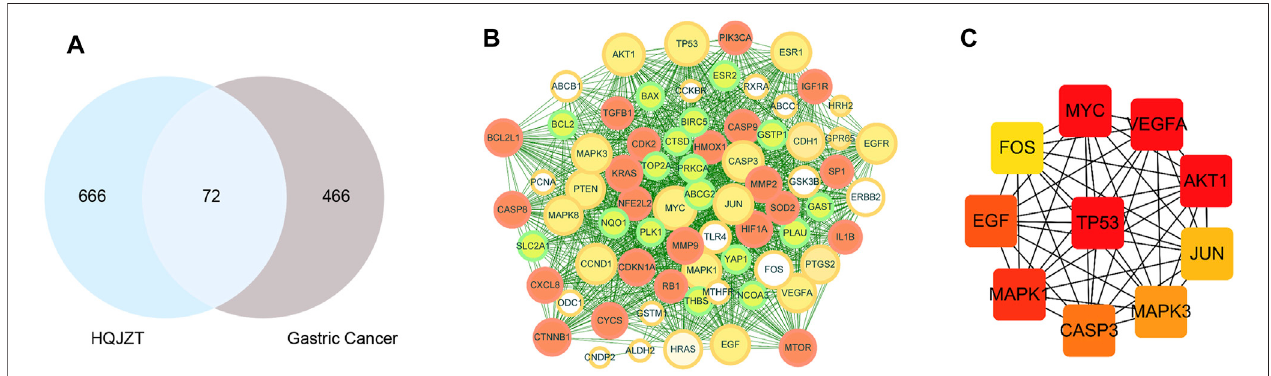
FIGURE 1 | (A) Venn diagram of the targets of Huangqi Jianzhong Tang (HJT) for the treatment of gastric cancer (GC). A total of 738 HJT-related targets and 538 GC-related targets were identi fi ed, and a total of 72 cross-targets were obtained using Venny. (B) The PPI network of the 72 cross-targets were constructed using Cytoscape. The size of nodes represents their degree values. (C) The top 10 hub genes were screened from (B) using CytoHubba.